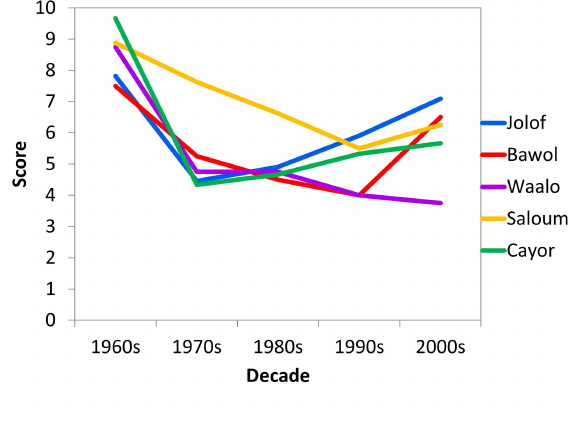
Fig. 7. Perceptions (average matrix scores) of the evolution of rainfall amounts from the 1960s to the 2000s, averaged by